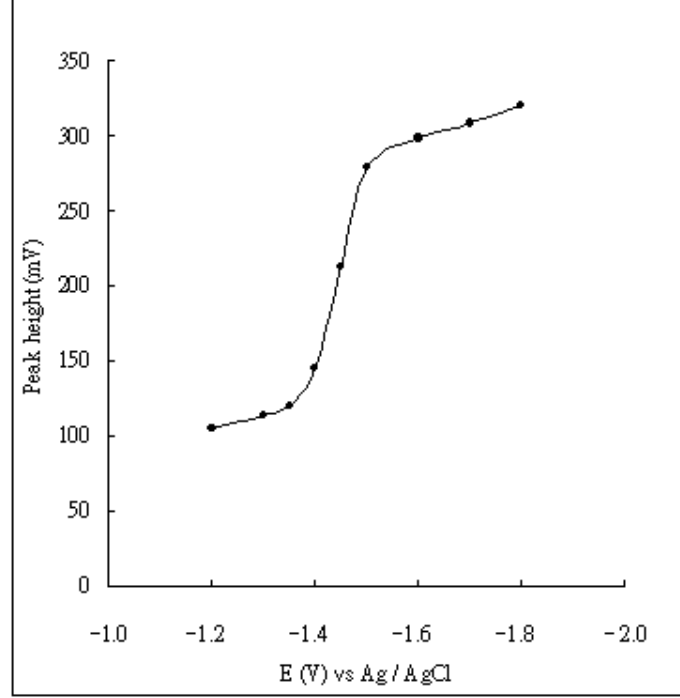
Figure 8. Hydrodynamic voltammogram obtained for NDELA (20 µ g) using an Hg/Au detector. Stationary phase, Phenomenex Luna CN column (particle size, 5 µ m; 250 mm × 4.6 mm i.d.); Mobile phase, methanol:water (10:90, v/v) containing 0.2 mM lithium perchlorate; flow rate, 0.3 ml/